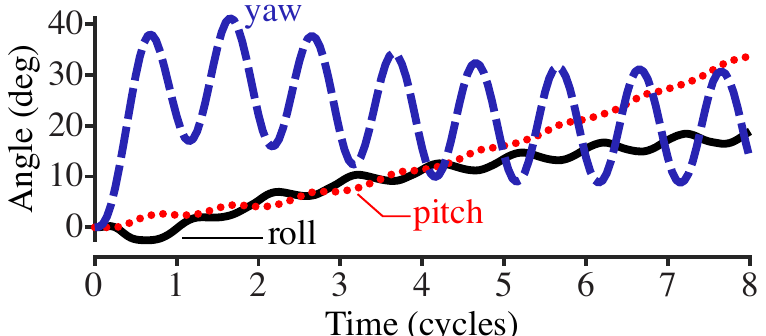
Figure 3. Plot of the roll, pitch, and yaw of the fish body with respect to the cycle phase. The fish body is driven by an applied torque with a frequency of 0.75